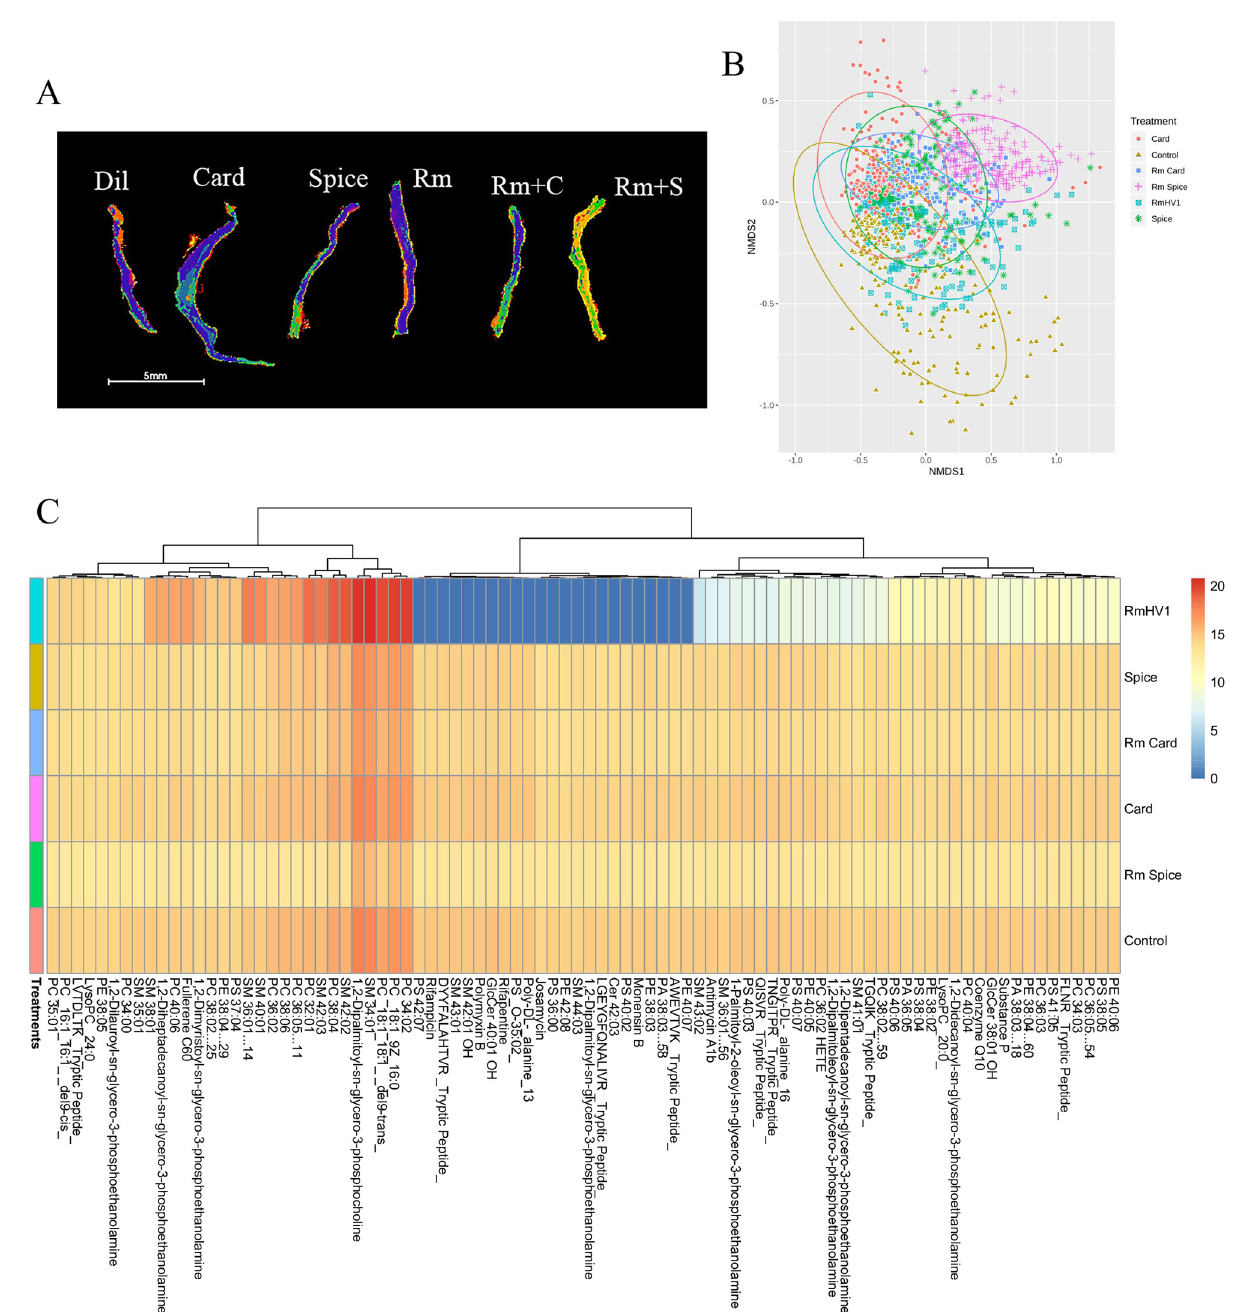
Fig 4. TRPA1 blockade alters metabolic response to AD models in mice. Ears from mice treated with TDI as in Fig 3 were collected and examined by imagine mass spec. (A) Segmentation for representative ear, (B) NMDS similarly plot, and all of the metabolites that were identified by both m/z and collisional cross section (C) are shown. Data represent two independent experiments and calculated using ANOVA. Dil = diluent, Card = cardamonin, Spice = ground cardamom seeds, Rm = Roseomonas mucosa, Rm+C = R . mucosa and Card, Rm + S = R . mucosa and Spice. Our findings beget a working hypothesis in which (di)isocyanate exposure induces dysbio- sis [9] through carbamoylation of the amine-groups on the ceramide-sphingolipid family of lipids [37] needed for proper skin barrier function [38]. While altering commensal metabo- lism, (di)isocyanates may also directly activate TRPA1 to induce itch, rash, Th2 cytokines, and